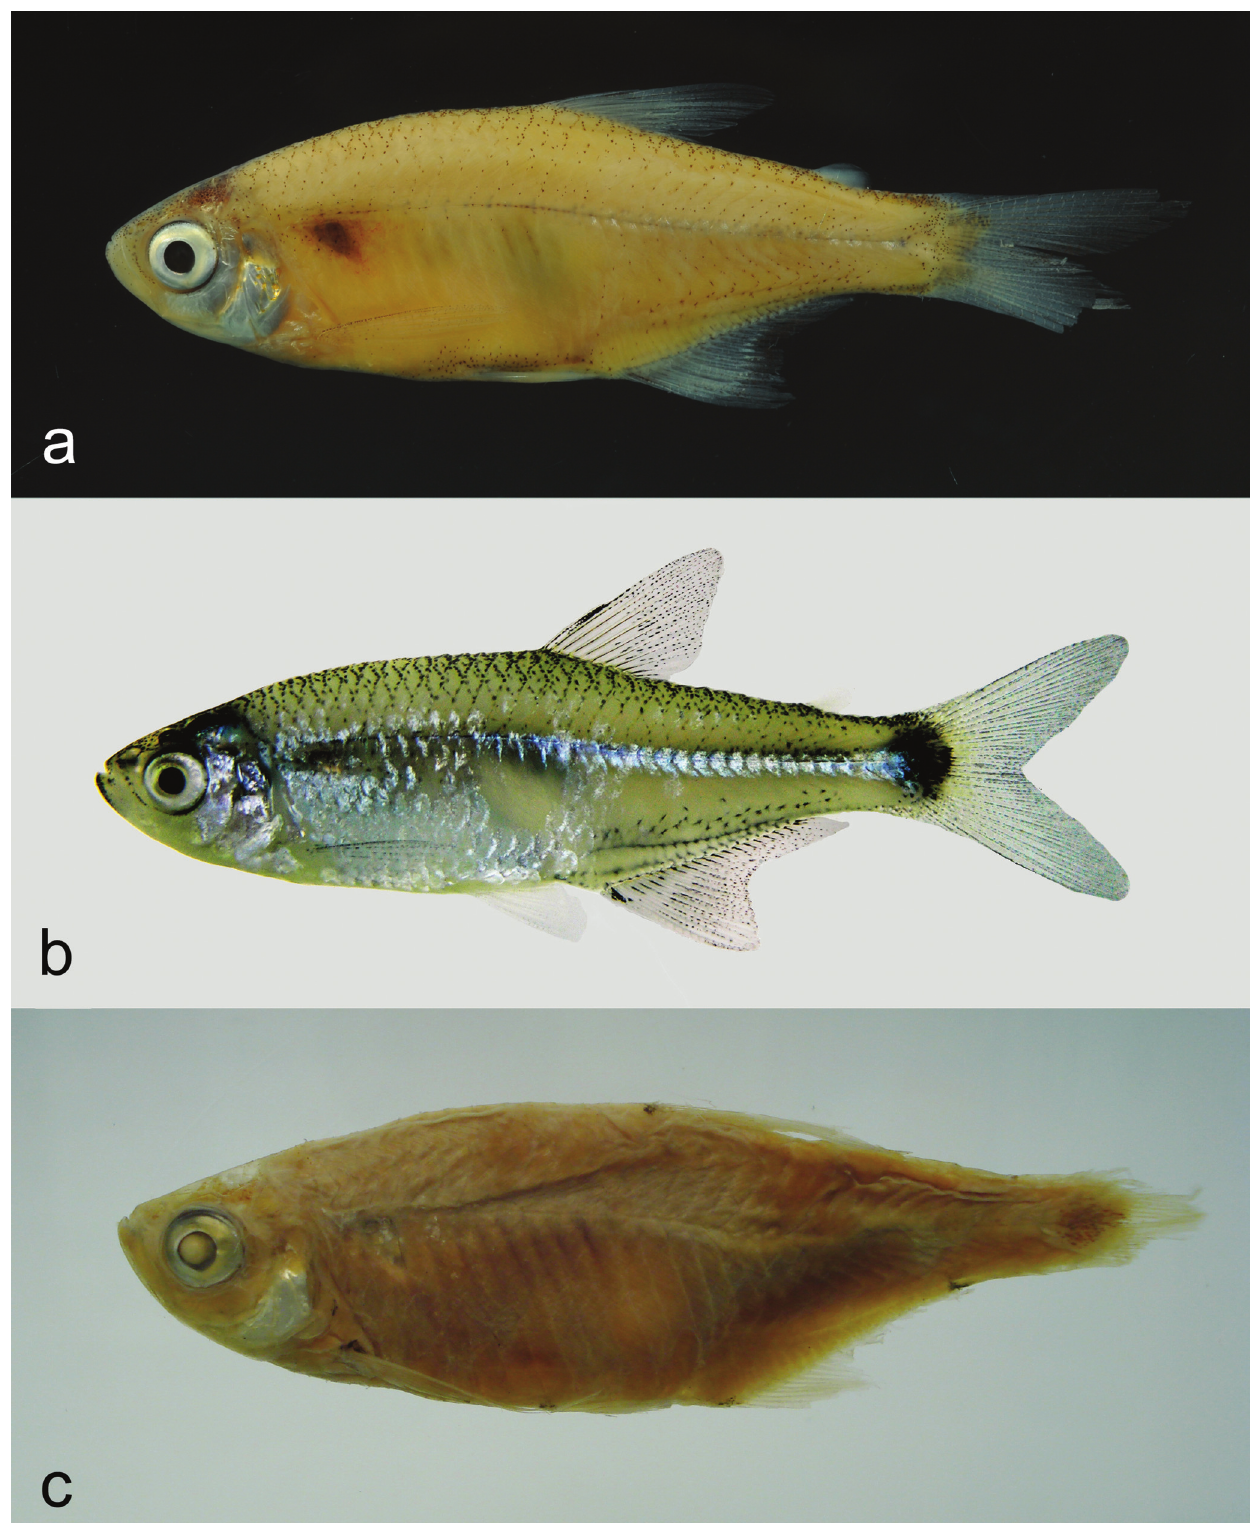
Fig. 1. Macropsobrycon uruguayanae , a - ANSP 168826, 32.8 mm SL, Uruguay, Depto. Cerro Largo, pool of rio Negro; b - specimen alive, not preserved; c - holotype, FMNH 57910, 36.0 mm SL, Brazil, Cacequy, rio Uruguay